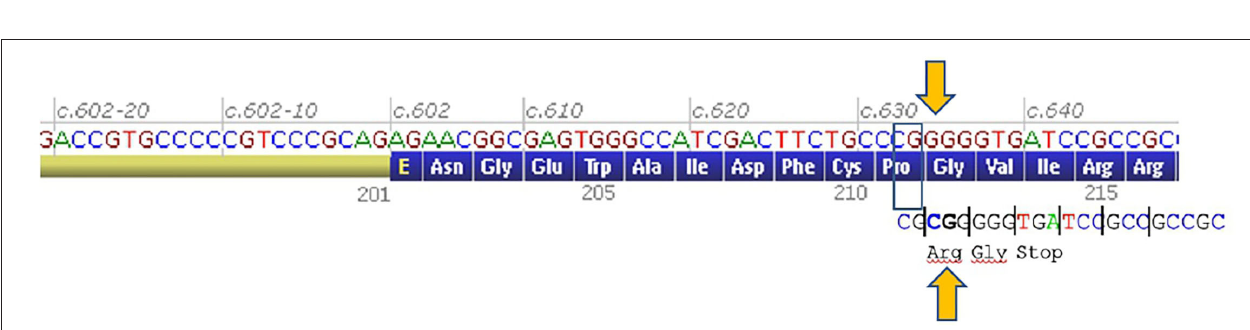
FIGURE 2 | Clinical features, P2. P2, an 8-year-old girl presenting with sever bilateral ptosis before treatment with salbutamol (A) ; amelioration of the eyelid ptosis (B) ; amelioration of strength in neck extensor muscles (C) .